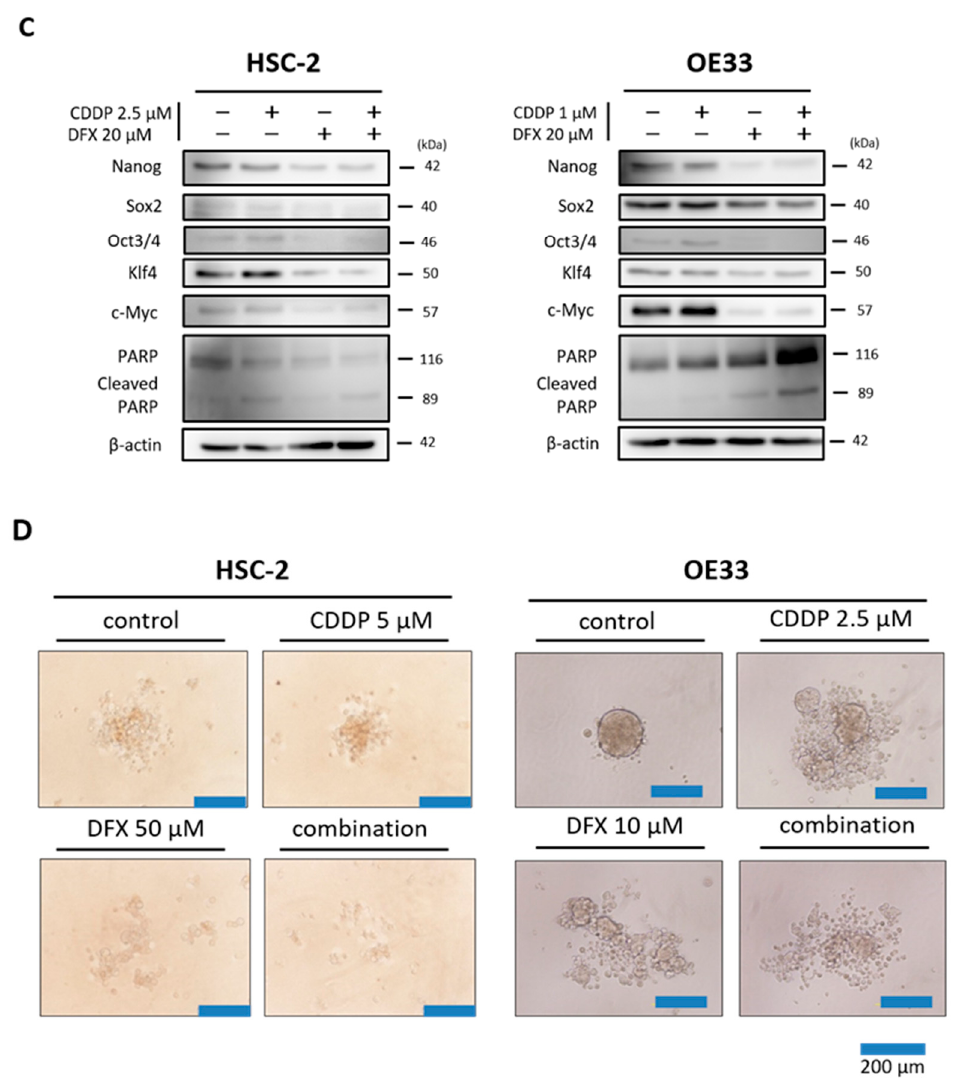
Figure 5. Effect of CDDP and DFX on cell growth and expression of stemness markers and function in vitro. ( A ) Inhibition of cell growth was evaluated using the XTT assay. Combined treatment with CDDP and DFX inhibited the growth of HSC-2 and OE33 cells in a dose-dependent manner compared with single agent treatment. ( B ) The combination index was analyzed with Calcusyn software using the results of the XTT assay. Several drug dose combinations of CDDP and DFX indicated synergism (Combination index < 1.0) of the combination treatment. ( C ) Expression of stemness markers was evaluated with western blot analysis. β -actin was used as a loading control. DFX and combination treatment suppressed the expression of stemness markers (Nanog, Sox2, Oct3/4, Klf4, c-Myc) in HSC-2 and OE33 cells. ( D ) Spherogenecity was evaluated with sphere formation assay in a 96-well ultra-low attachment plate. DFX and combination treatment suppressed the spherogenecity in HSC-2 and OE33 cells.